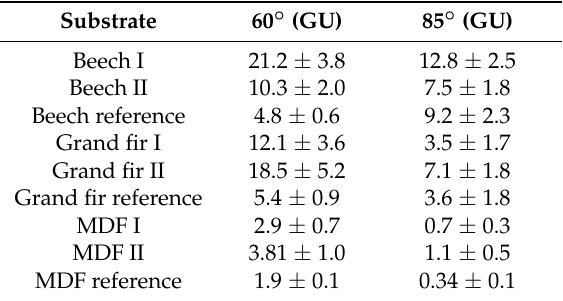
Table 3. Gloss measurements of coated and uncoated substrates ( N =